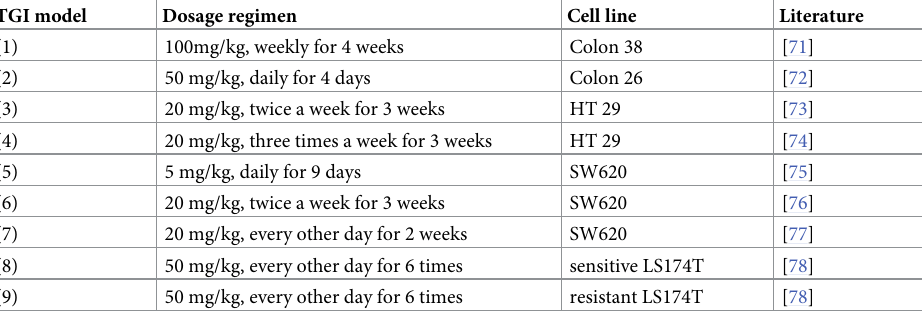
Table 3. The nine different dosage regimens that are evaluated in our